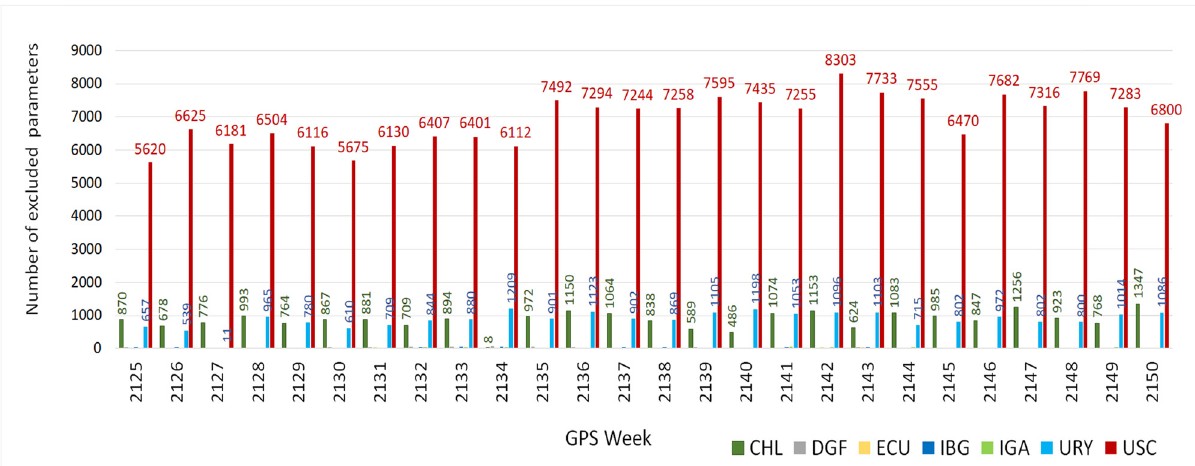
Figure 4: Number of tropospheric parameters excluded ( σ ZTD i > 0.02 m ) , per week, per AC. Period 6 months ( September 2020 to March 2021 ) .